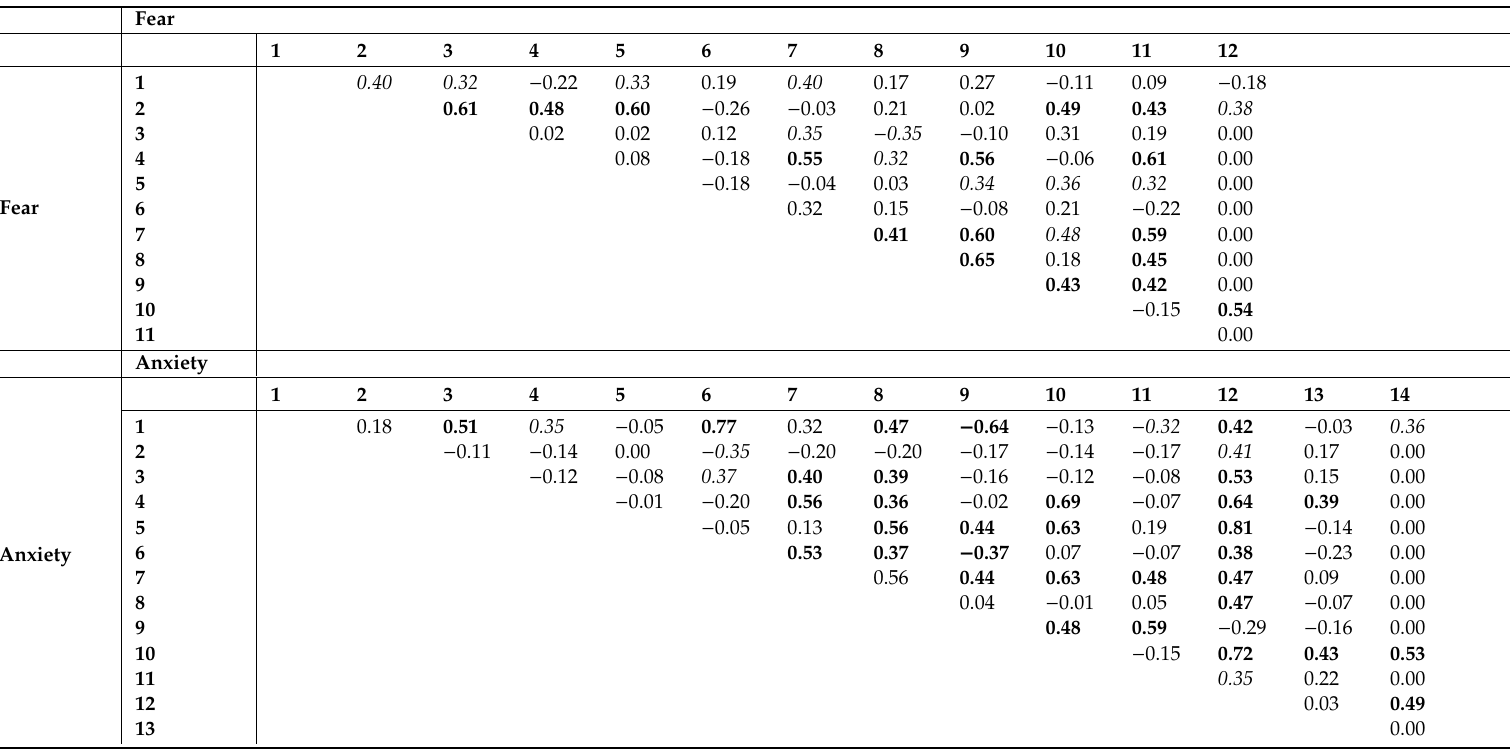
Table 5. Spearman Rank correlation coe ffi cients between behaviours recorded in the formal behaviour assessment in shelter dogs ( n = 38) (Numbered behaviours relate to those presented in Table